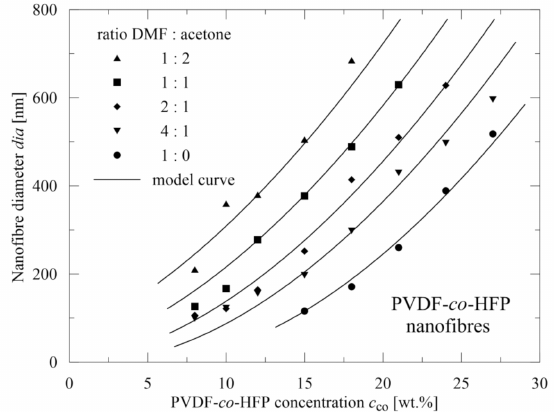
Figure 9. A course of a mean nanofibers diameter and its